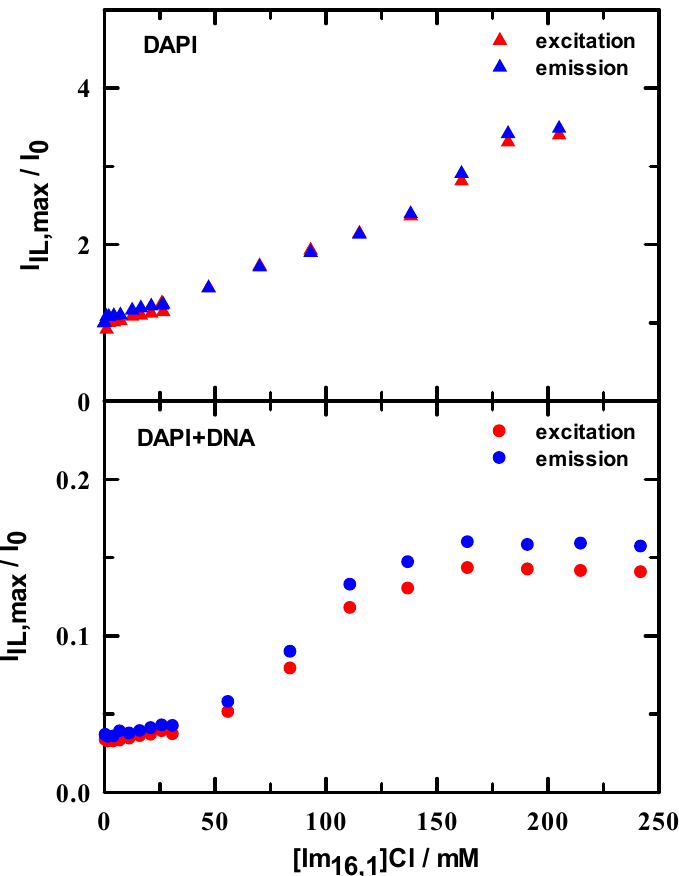
Figure 5. Spectral intensity ratios in 10 mM tris buffer at pH = 7.0 as a function of added IL deter- mined by ratioing intensity in the presence of IL to that in the absence of IL. Upper panel: DAPI excitation ( (cid:78) ) and emission ( (cid:78) ) ratios. Lower panel: DAPI + DNA duplex excitation ( • ) and emission ( • ) ratios.